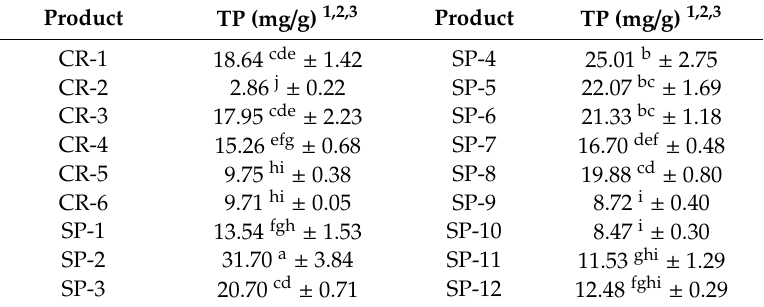
Table 3. Total phenolic (TP)content for extracts of U. tomentosa commercial products.